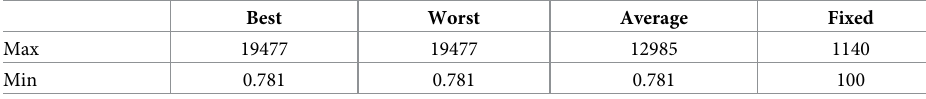
Table 11. Max and min values of weighting matrix in each